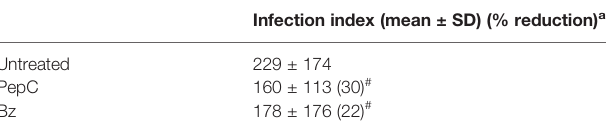
TABLE 3 | Activity of peptide C (PepC) and benznidazole (Bz) on in-vitro infection of peritoneal mouse macrophages (PMM) by Trypanosoma cruzi (Y strain) using pretreatment protocol: mean ± SD of the infection index (% of reduction).